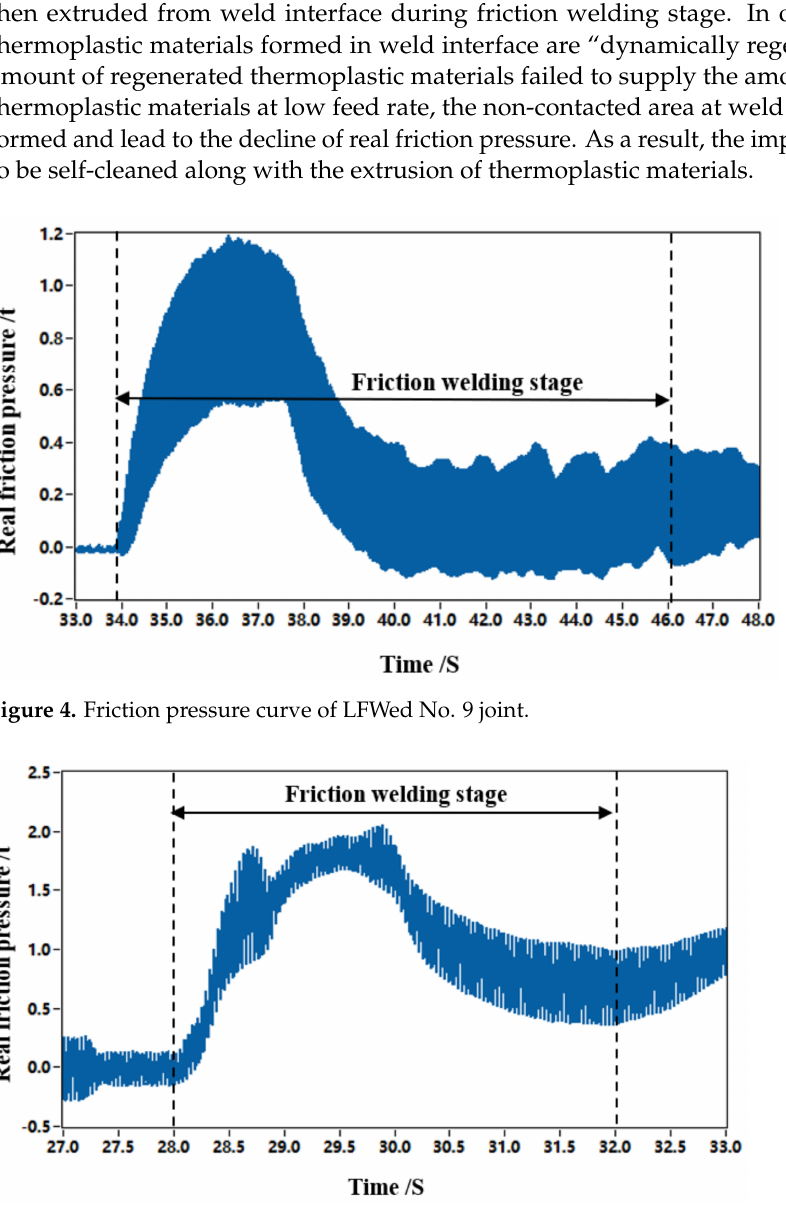
Figure 5. Friction pressure curve of LFWed No. 12